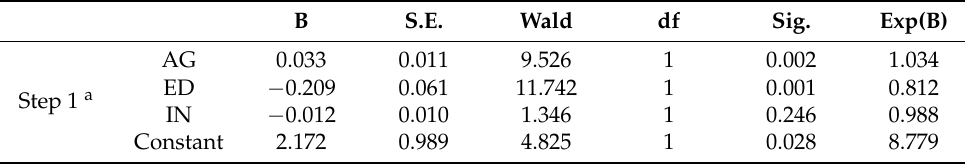
Table 16. Variables in the